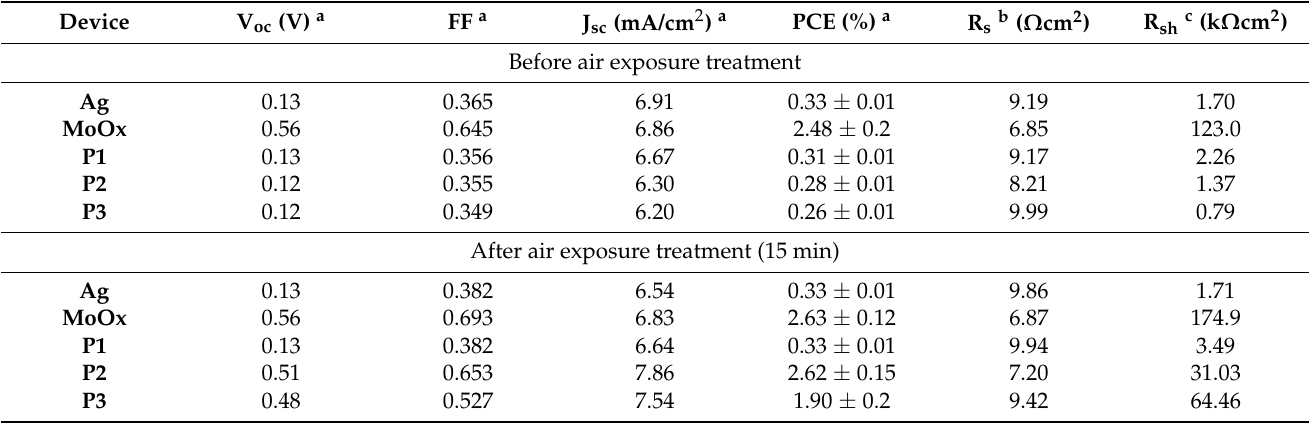
Table 2. Summary of the photovoltaic parameters a using pristine Ag or MoOx, P1 , P2 , and P3 AILs before and after an air exposure treatment of 15 min.